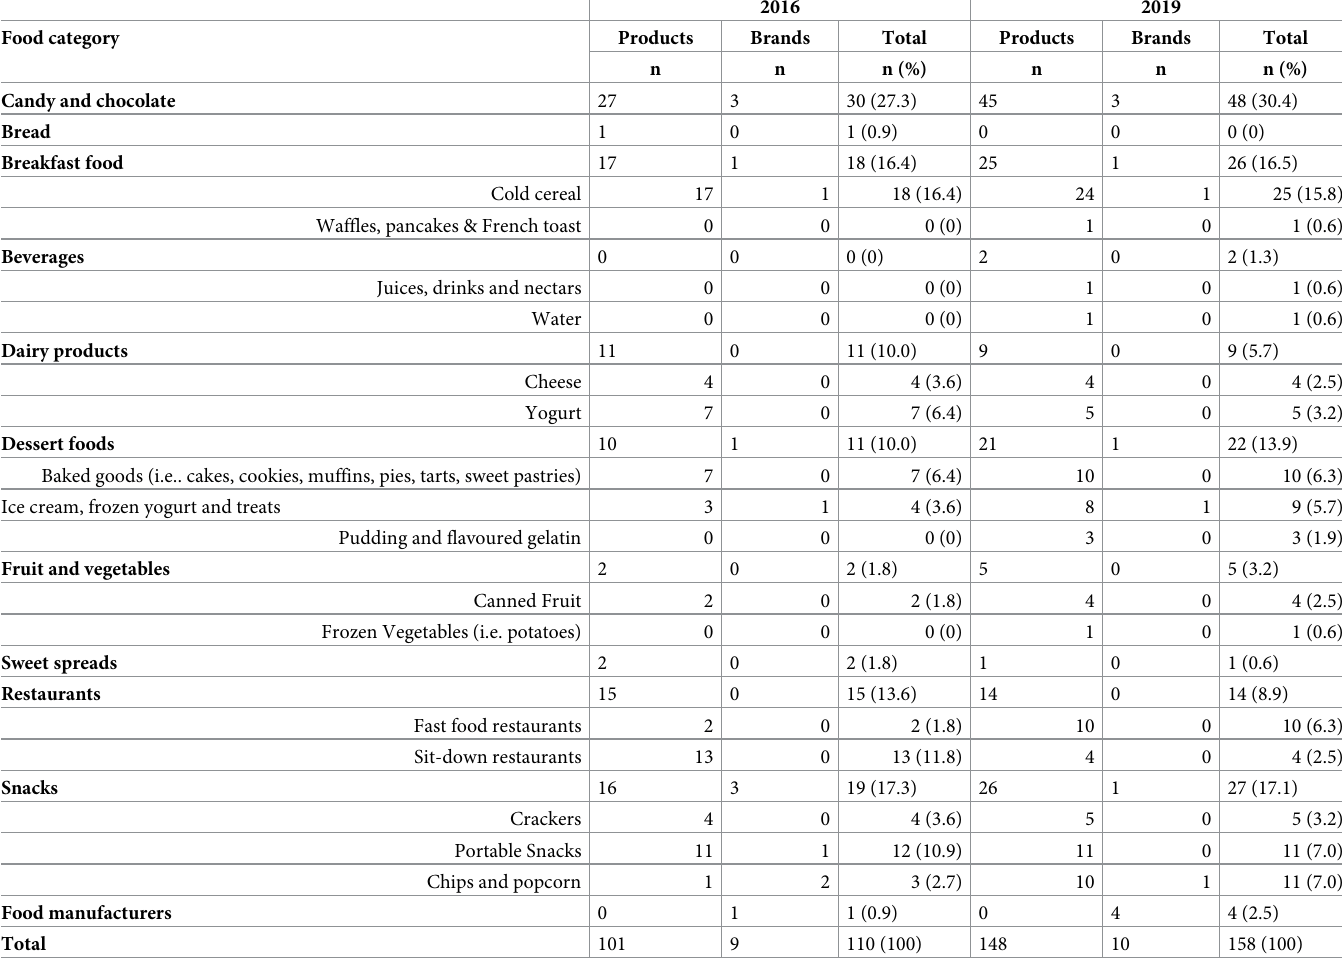
Table 2. Number of products or brands considered child-targeted † by product category and